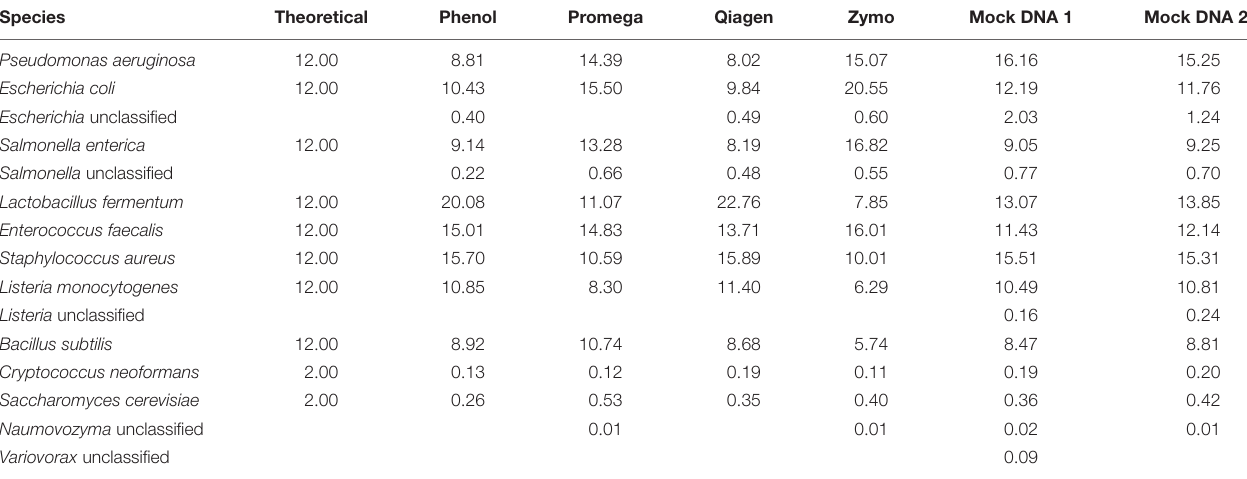
TABLE 3 | Mock community controls to identify bias in extraction